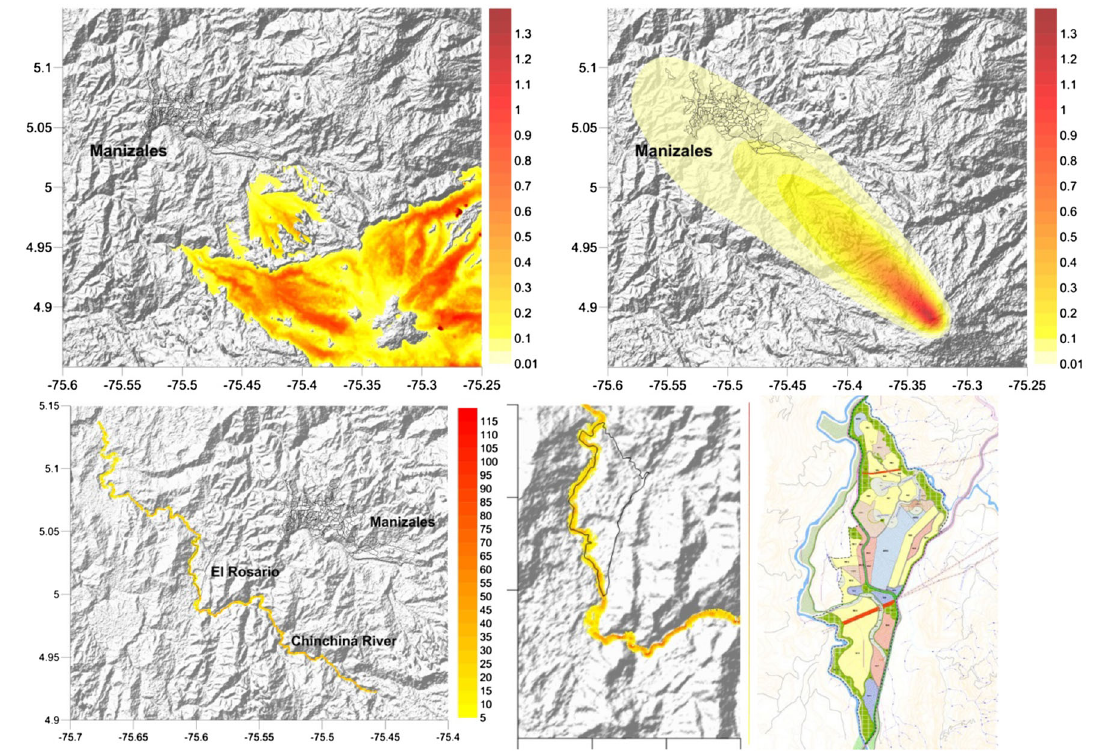
Fig. 3 Top left PDC dynamic pressure hazard map (in Pascals). Top right Ash fall thickness for the worst-case scenario eruption of Nevado del Ruiz (in meters). Bottom left Lahar hazard inundation